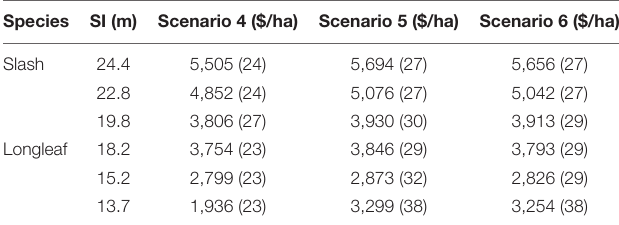
TABLE 6 | Land expectation values for loblolly, slash, and longleaf pines across site indices with income from pine straw